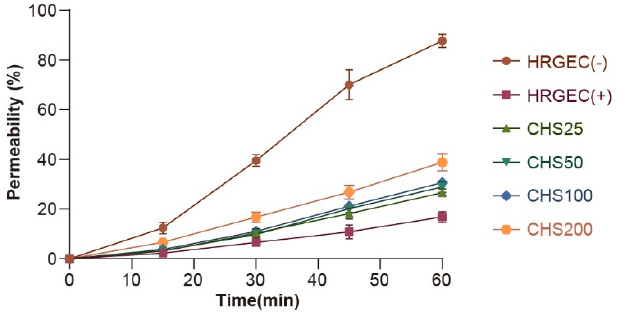
Figure 5. Effect of AO on the permeability of the glomerular endothelial barrier in a transwell chamber. The cells were treated with AO at different concentrations (25 µ M to 200 µ M) for 48 h, and the permeability of the glomerular endothelial barrier to FITC-IgG was measured within 60 min.